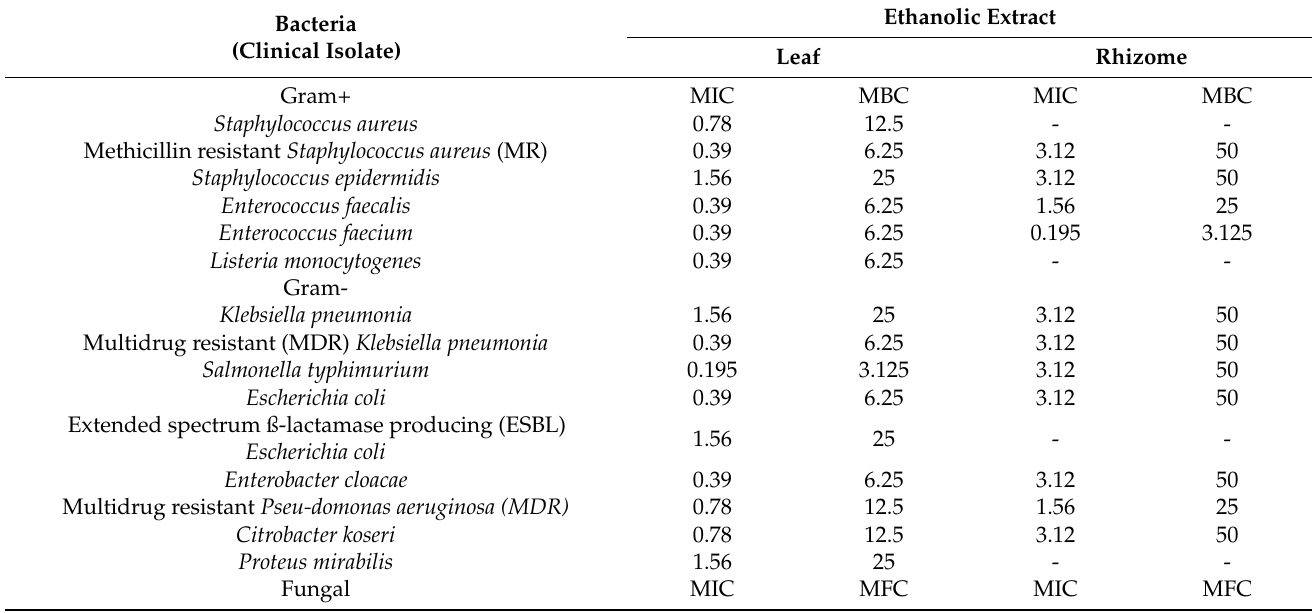
Results correspond to the mean ± standard deviation of three replicates. Different letters within the same row mean that there are significant differences ( p < 0.05). Gent: gentamicine. Strepto: streptomicin, Amph B: amphotericine B. Diameter of disc used is equal to 6 mm. Table 5. Minimal inhibition concentrations (MICs), minimal bactericidal concentrations (MBCs) (mg/mL) and